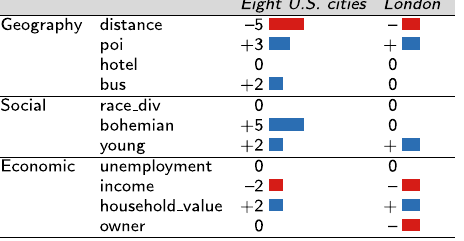
Eachcellunderthecolumn‘EightU.S.cities’indicatesthenumberofstandardized β coefficientsthatarestatistically significantandhigherthan0.15inabsolute terms;suchnumber ispositiveiftherearemoreinstances(i.e.,cities)withinthat modelsetwiththevariablehavinga(significantly)positivecoefficient,andnegativeotherwise.Eachcellunderthecolumn ‘London’indicateswhetherthecorrespondingcorrelationwassignificantpositive( + ),orsignificantnegative( – ),orrathernot significantlycorrelated(0).Thevariables‘popDens’, ‘income_div’,‘talent’and‘poverty’arenotreportedsincethesame parameterswerenotconsideredinthestudy proposedbyQuattrone etal.